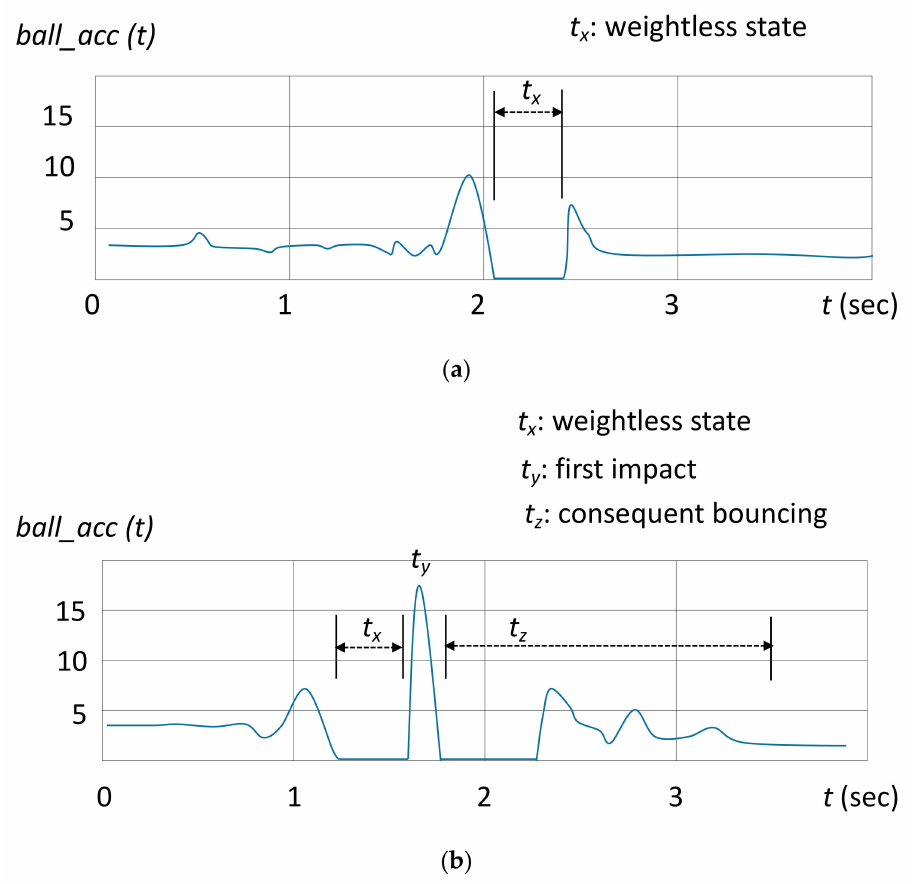
Figure 5. Illustrations of signals from ball_acc : ( a ) throw and catch successfully, where the signal was cut o ff (i.e., period “ t x ”) due to the weightless state as the sensor stays in the air, ( b ) throw without catching successfully, where “ t y ” was the first impact of the ball to the ground and was followed by another weightless period with a series of pulses due to the bounces of the ball (i.e., period “ t z ”). C.